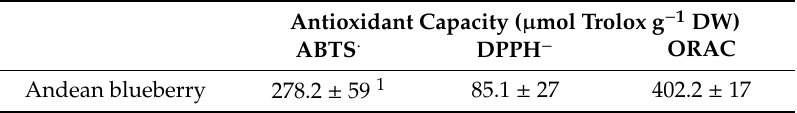
Table 4. Antioxidant capacity of Andean blueberry ( n = 3).